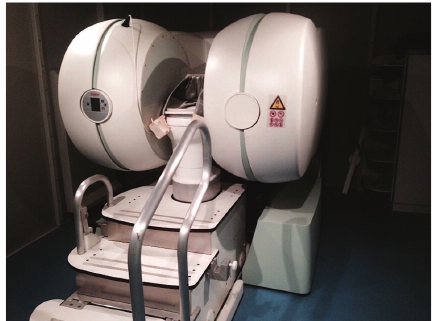
Figure 1: “Pelvic scan”